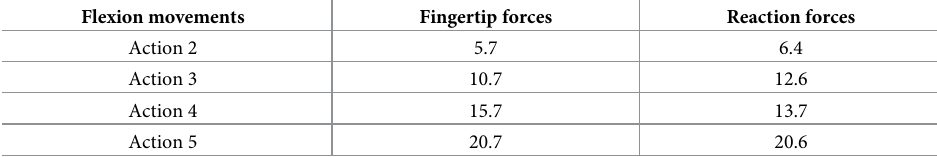
Table 3. Experimental fingertip forces and the rigid plate reaction forces (N).